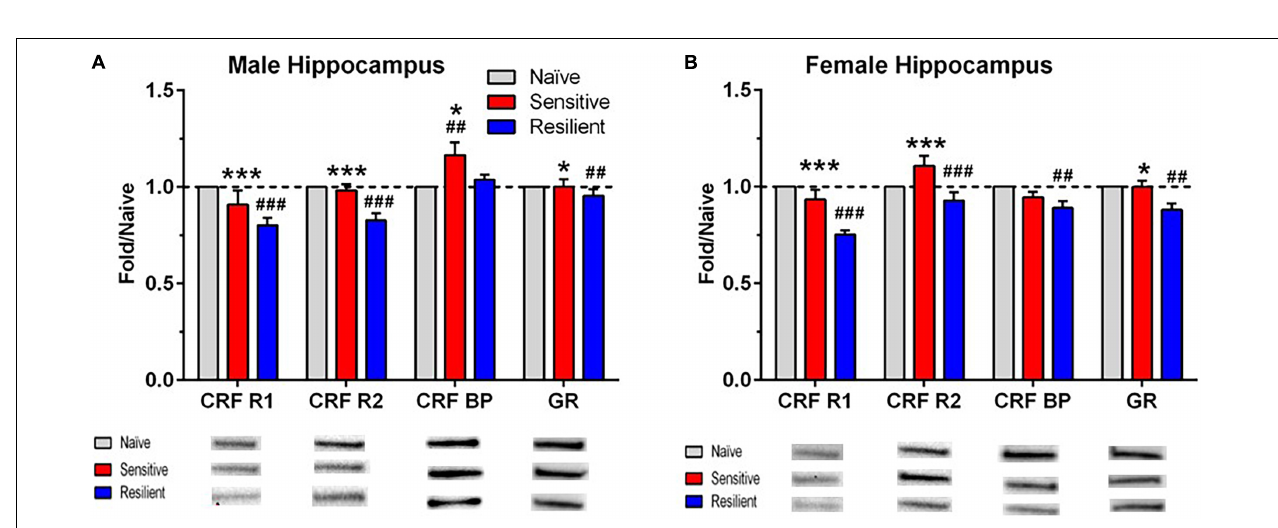
FIGURE 6 | Sex- and subgroup-dependent changes in protein levels related to stress-regulating systems in the hippocampus after a history of ethanol drinking and intermittent predator stress exposure. There were treatment- and subgroup-induced alterations in the proteins examined, with sex differences only observed for CRF-BP. Representative animals from the “sensitive” and “resilient” subgroups depicted in Figures 2 , 3 were chosen for the Western blot analyses, and values were compared to separate groups of naïve mice. Values are mean ± SEM levels that were normalized to β -actin and then normalized to the respective naïve group (dashed line) for male (A) and female (B) mice. Changes in relative protein levels were compared using normalized optical density measurements. Representative bands from the immunoblots for each protein are included beneath each panel on the graph. Representative immunoblots for each protein, brain region, and sex are depicted in Supplementary Figures 1–4 . Group size is the same as in Figure 5 . * p ≤ 0.05, *** p ≤ 0.001 vs. respective “resilient” subgroup; ## p ≤ 0.01, ### p ≤ 0.001 vs. respective naïve. The results depicted reflect either separate analyses for each sex (CRF BP) or analyses with the sexes combined (CRF R1, CRF R2, GR). See Table 2 for ANOVAs. CRF R1, corticotropin releasing factor receptor 1; CRF R2, corticotropin releasing factor receptor 2; CRF BP, corticotropin releasing factor binding protein; GR, glucocorticoid